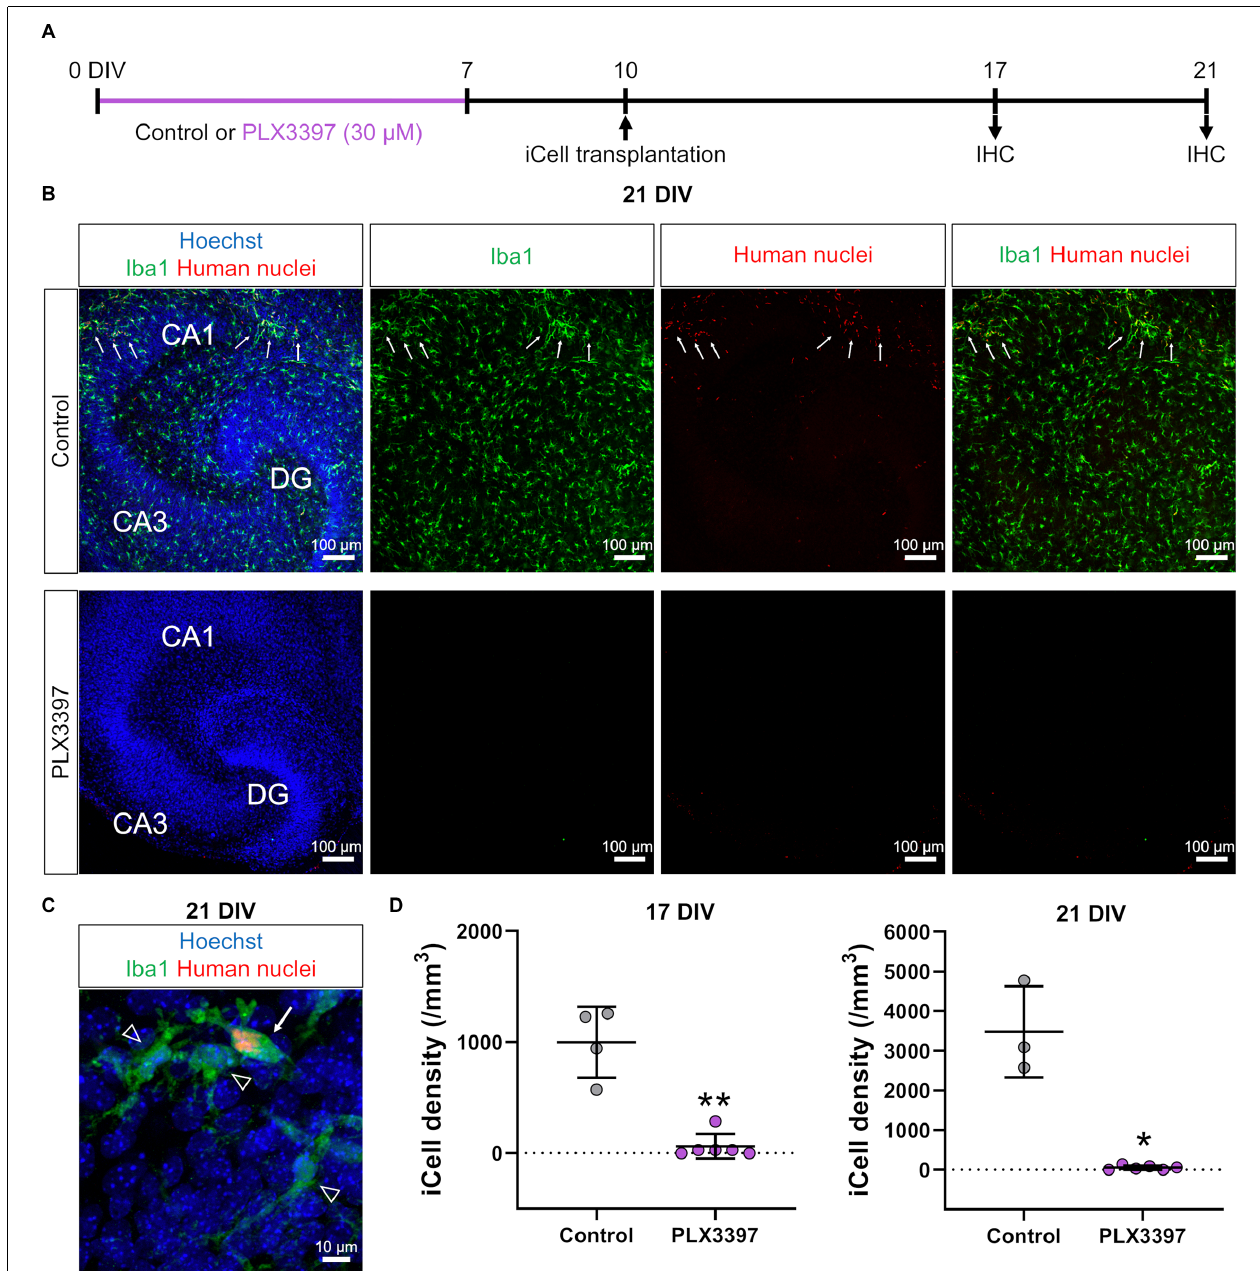
FIGURE 1 | PLX3397 attenuated the transplantation of iCell-MG in slice cultures. (A) Experimental paradigm. IHC: immunohistochemistry. (B) Representative images of iCell-MG-transplanted slices at 21 DIV cultured with (lower) or without (control, upper) 30 µ M PLX3397. Cultures were immunostained for Iba1 (green) and human nuclei (red). Nuclei were stained with Hoechst (blue). Some iCell-MG were found in control cultures (upper panels, arrows). (C) Representative images of iCell-MG (arrow) and innate microglia (arrowheads) in control cultures. (D) iCell-MG density at 17 (left panel) and 21 DIV (right panel). In PLX3397, iCell density was zero in two of the six slices at 17 DIV and 21 DIV. ** p < 0.01 and * p < 0.05, Mann-Whitney rank sum test, n = 4 (17 DIV in control), six (17 DIV in PLX3397), three (21 DIV in PLX3397), and six (21 DIVin PLX3397) slices, each from three mice. Data represent the mean ±